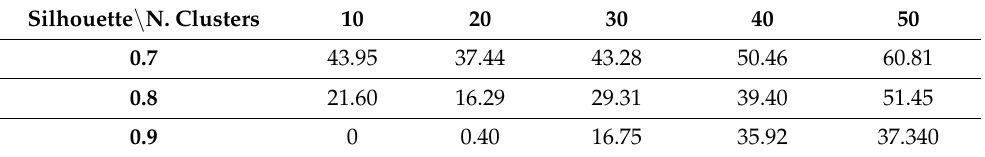
Table 1. Clustering performance in terms of silhouettes using original data. Silhouette \ N. Clusters